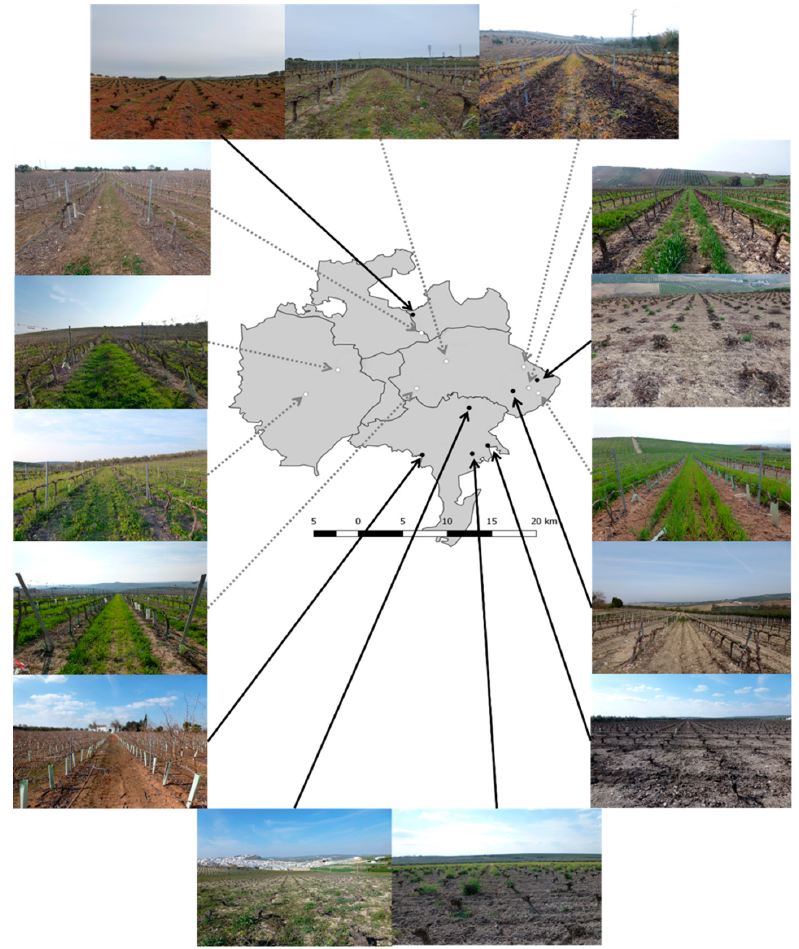
Figure 1. Views of the fifteen vineyards studied in the Montilla-Moriles wine region, near Córdoba, Andalusia, Spain. Black circles and solid arrows show vineyards with treatment bare soil; white circles and dotted arrows show treatment with inter-row vegetation cover. Adapted from [50] .